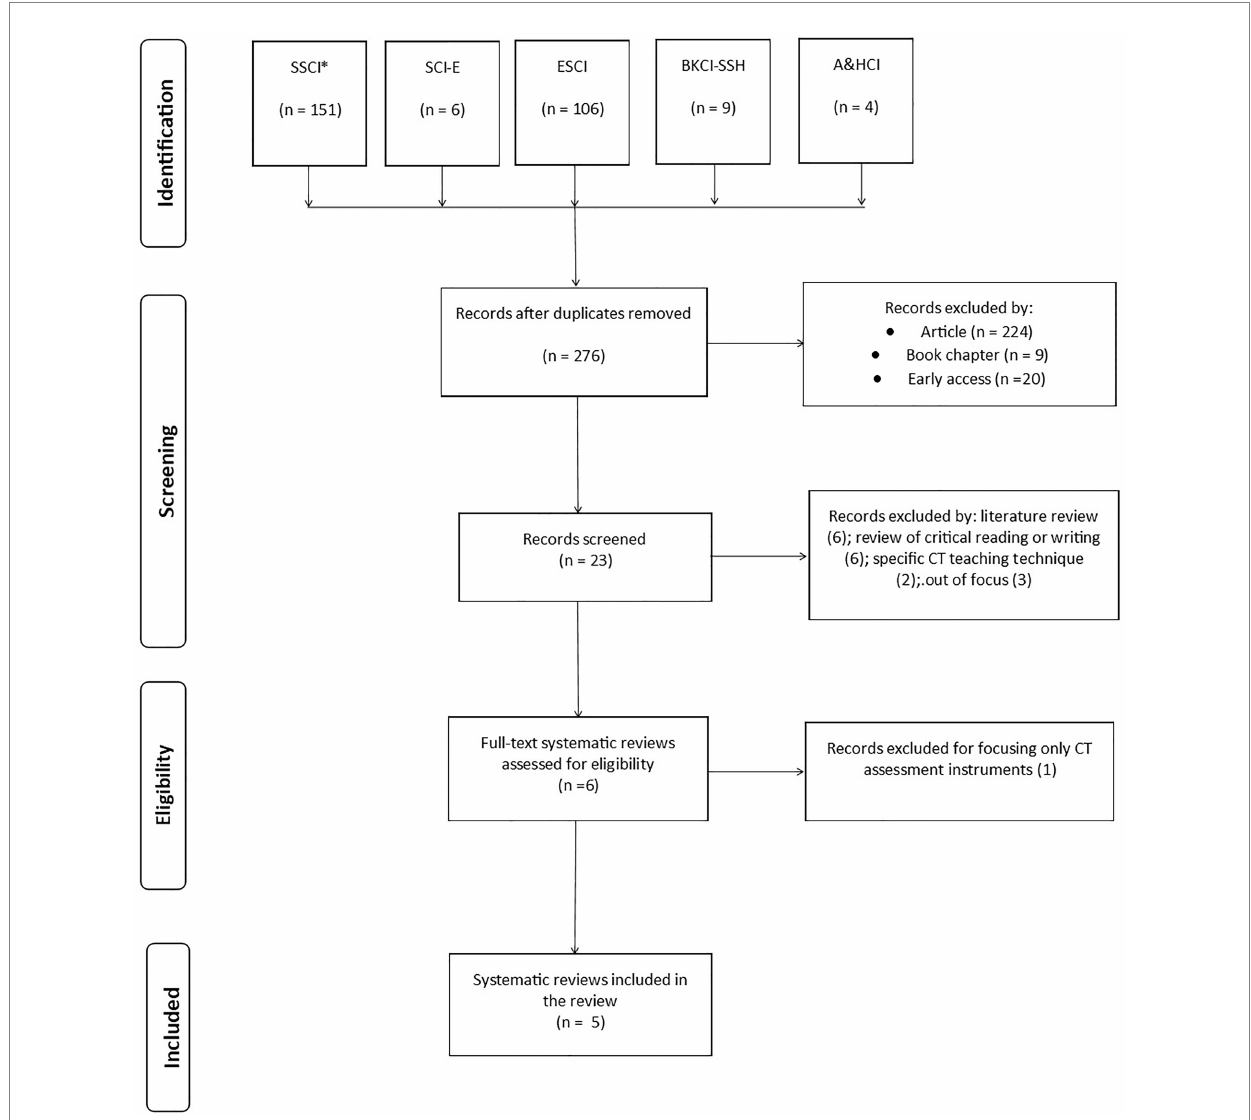
FIGURE 2 PRISMA 2020 diagram flow. *SSCI, Social Sciences Citation Index; SCI-E, Science Citation Index Expanded; ESCI, Emerging Sources Citation Index; BKCI-SSH, Book Citation Index Social Sciences & Humanities; A&HCI, Arts & Humanities Citation